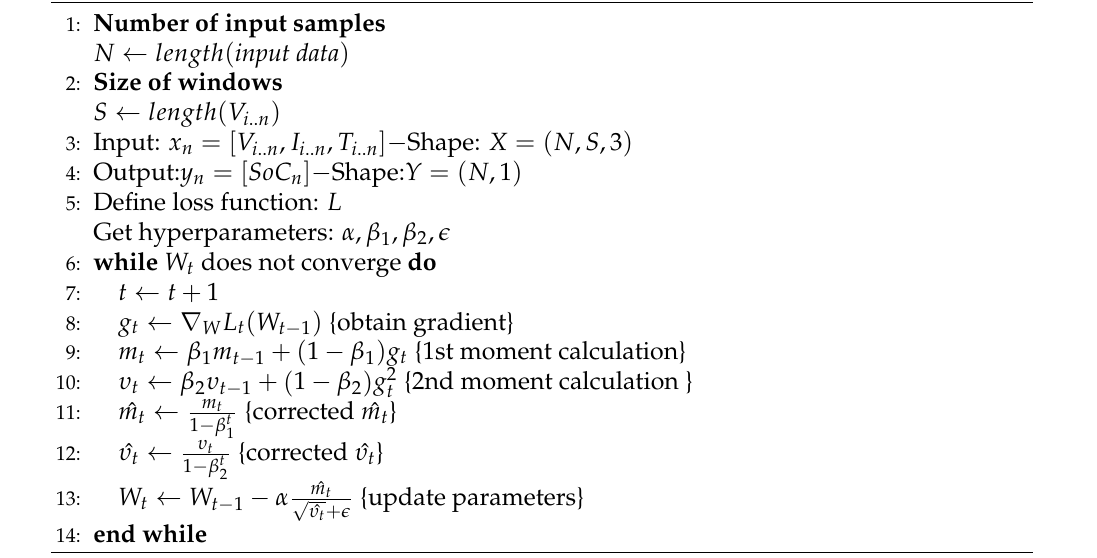
Algorithm 2 Adaptive moment estimation (Adam)